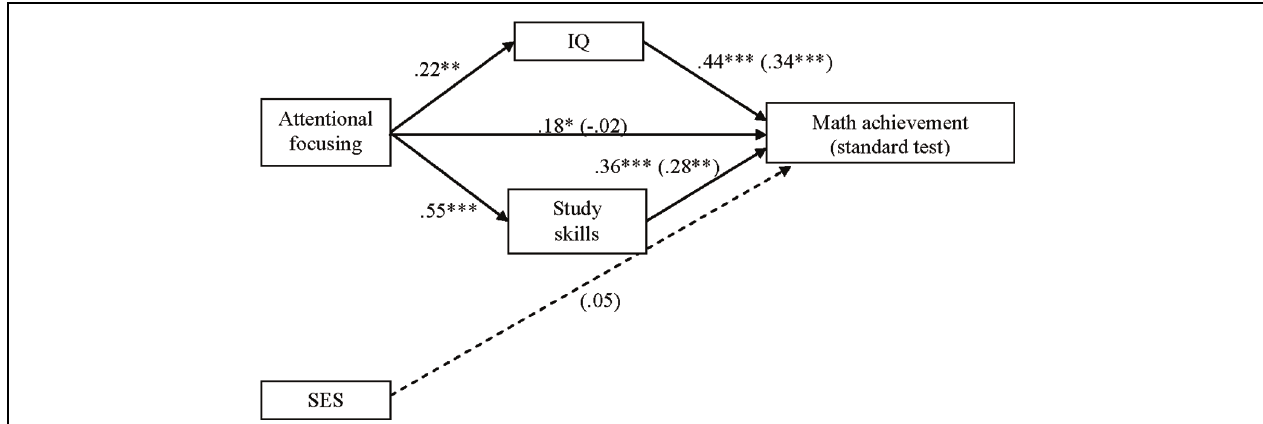
FIGURE 3 | Intellectual-abilities model with IQ and study skills as mediators in the AF and math achievement (standard test) association. Numbers in the figure are beta coefficients ( ˆ β for mediational model are in parentheses). ∗ p < 0.05; ∗∗ p < 0.01; ∗∗∗ p < 0.001.